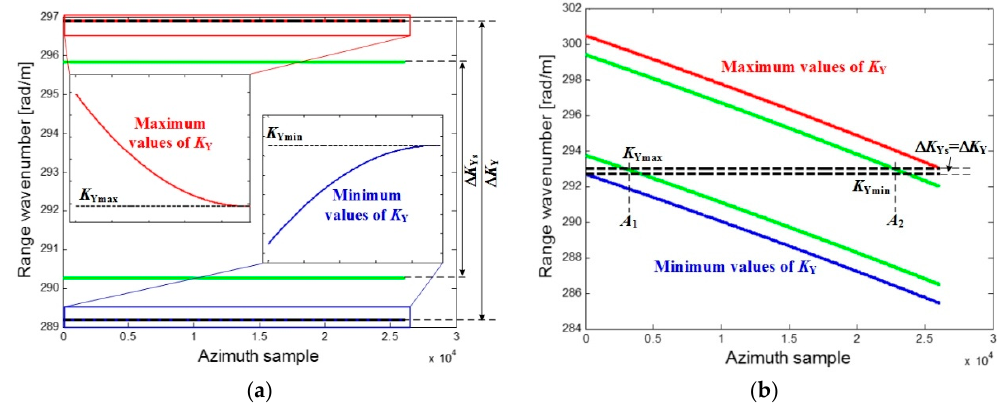
Figure 12. Range wavenumber when: ( a ) using the parameter adjusting technique; and ( b ) not using the parameter adjusting technique.